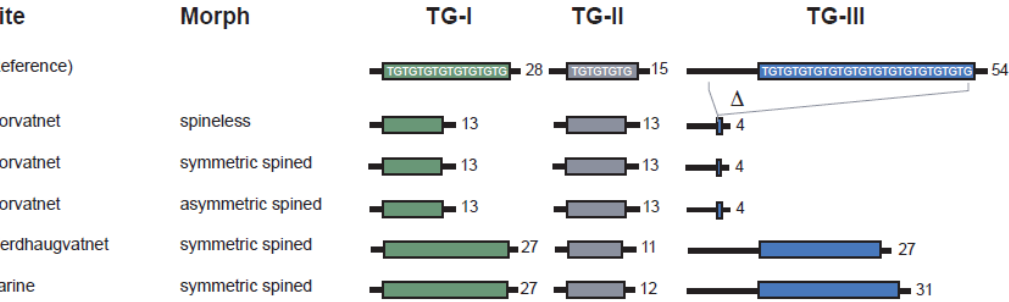
Figure 3. Representative examples of allelic variants of Pel A caused by variable numbers of TG dinucleotides at TG-repeats I–III. The repeat number of the most common allelic variants is shown for each of the five groups of sticklebacks examined. For more details see the Supplementary Figures S2 and S3.